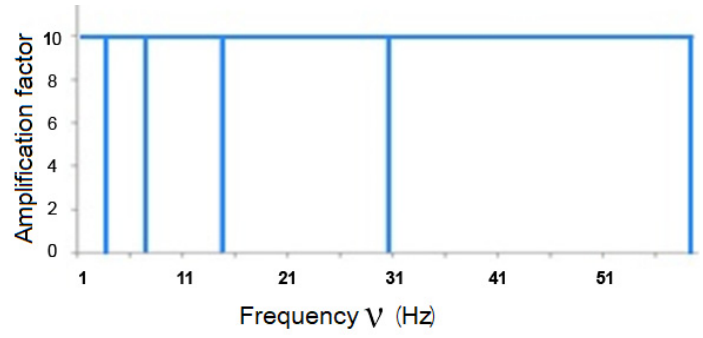
Figure 4. Frequency domains of strictly orthogonal wavelets.